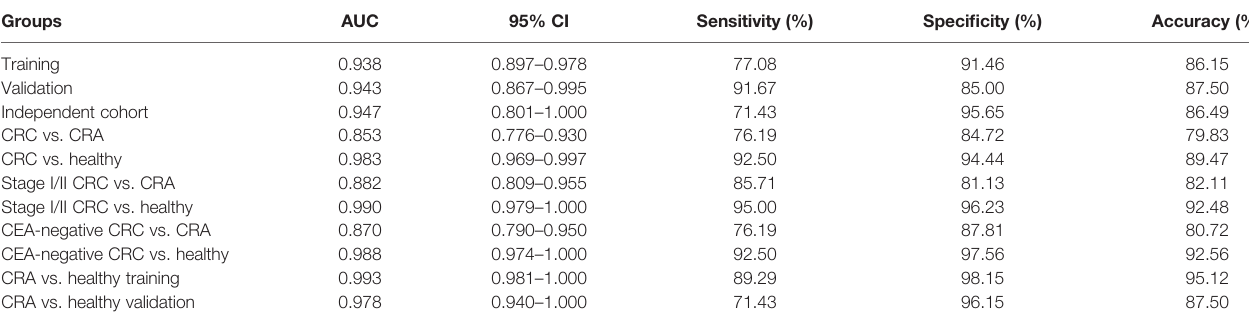
TABLE 3 | The exLR d-signature in diagnosis of CRC, CRA, and healthy participants. Groups